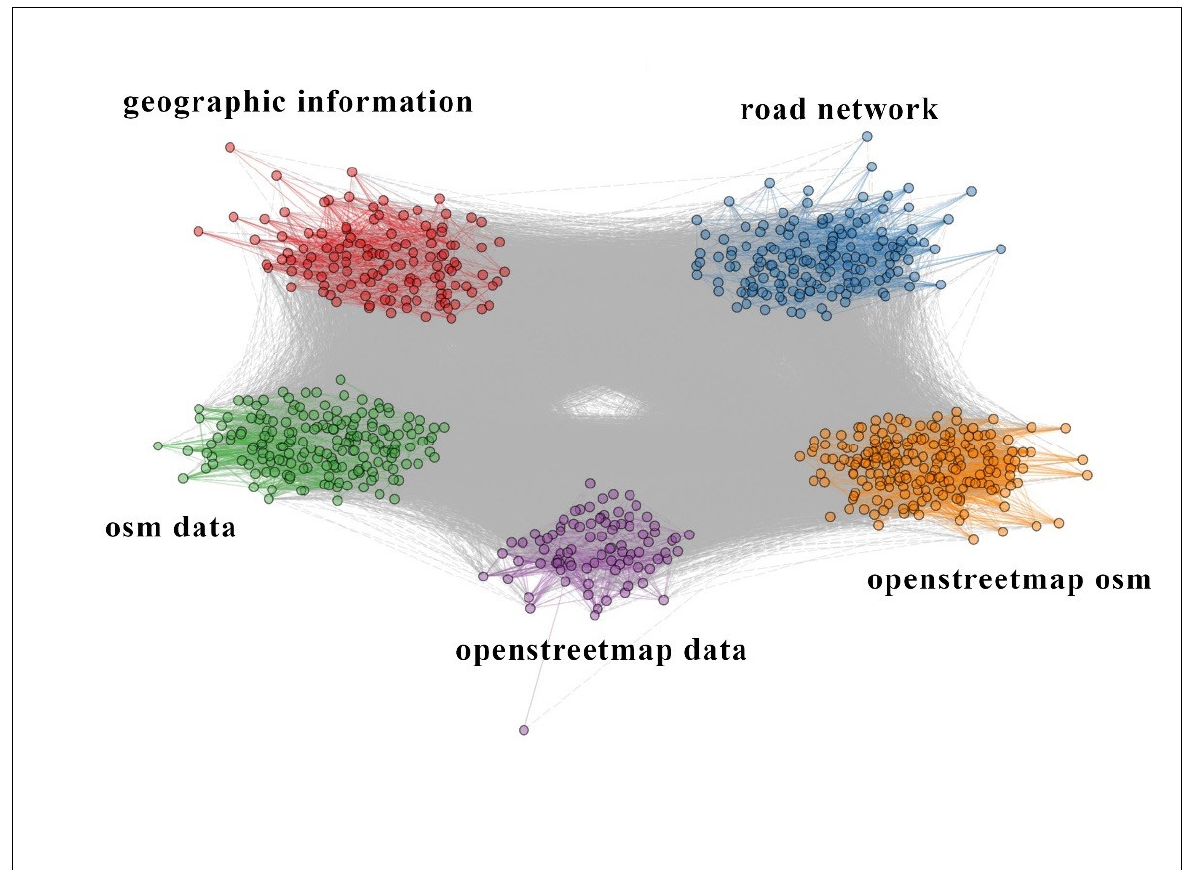
Figure 2. Co-occurrence network of the bigrams appearing at least ten times. The structure is characterised by five subnetworks: four with a larger size led by the bigrams “geographic information”, “road network” “osm data” and “openstreetmap osm” and one smaller led by the bigram “openstreetmap data”. Table 3. Indexes of the conceptual